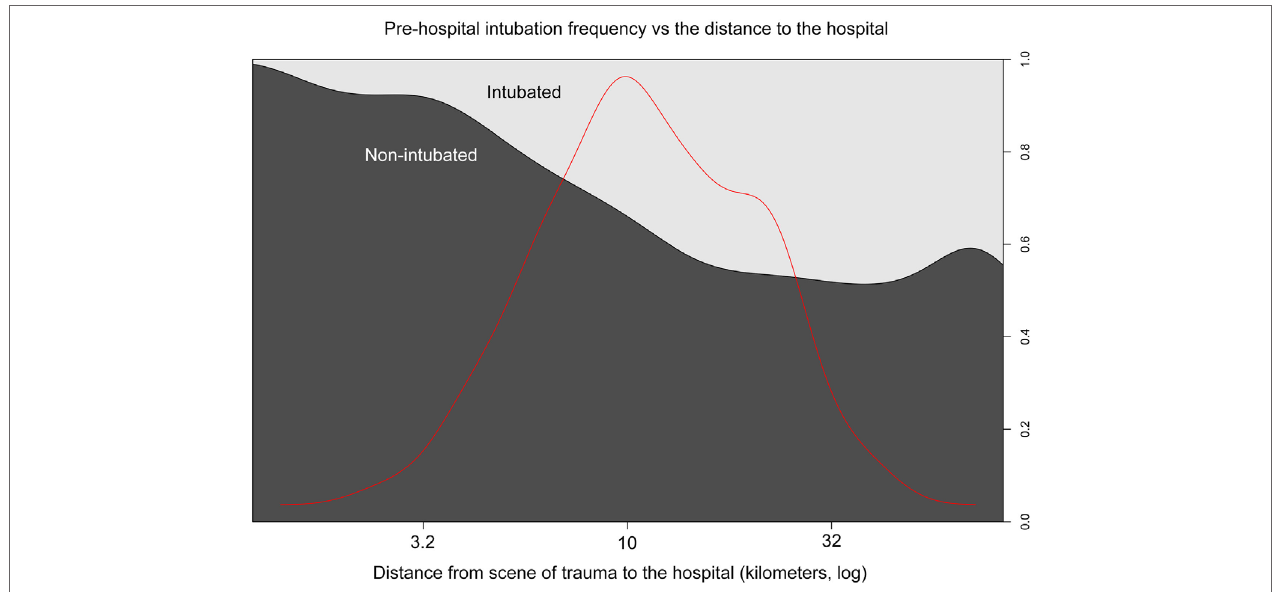
FigUre 1 | Intubation frequency and prehospital transport distance. Distance from the trauma to the hospital ( x -axis, kilometers log) and the proportion of prehospital intubation ( y -axis right). Bright represents intubated- and dark non-intubated patients ( y -axis left). The red line represents the data